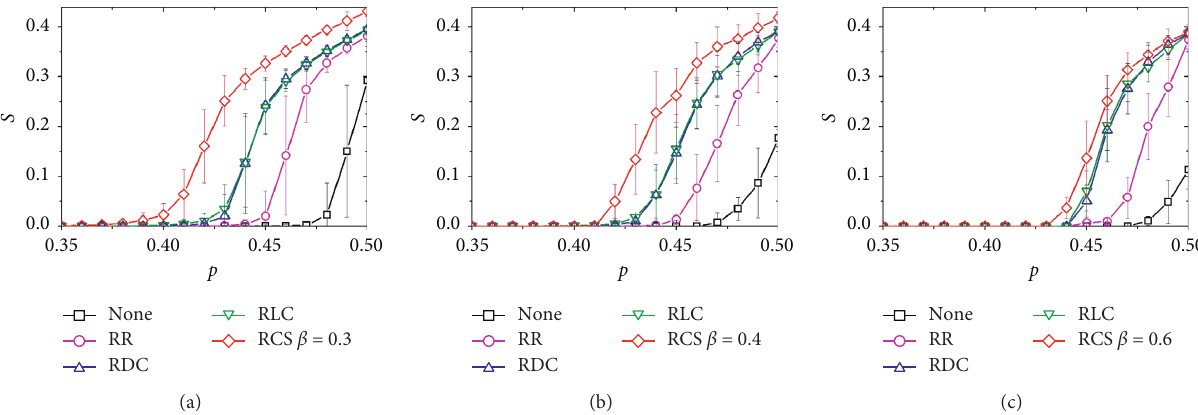
Figure 6: The size of the giant component S in the steady state of network as a function of the fraction of surviving nodes p . (a) ICNs with ER-ER structures. (b) ICNs with ER-SF structures. (c) ICNs with SF-SF